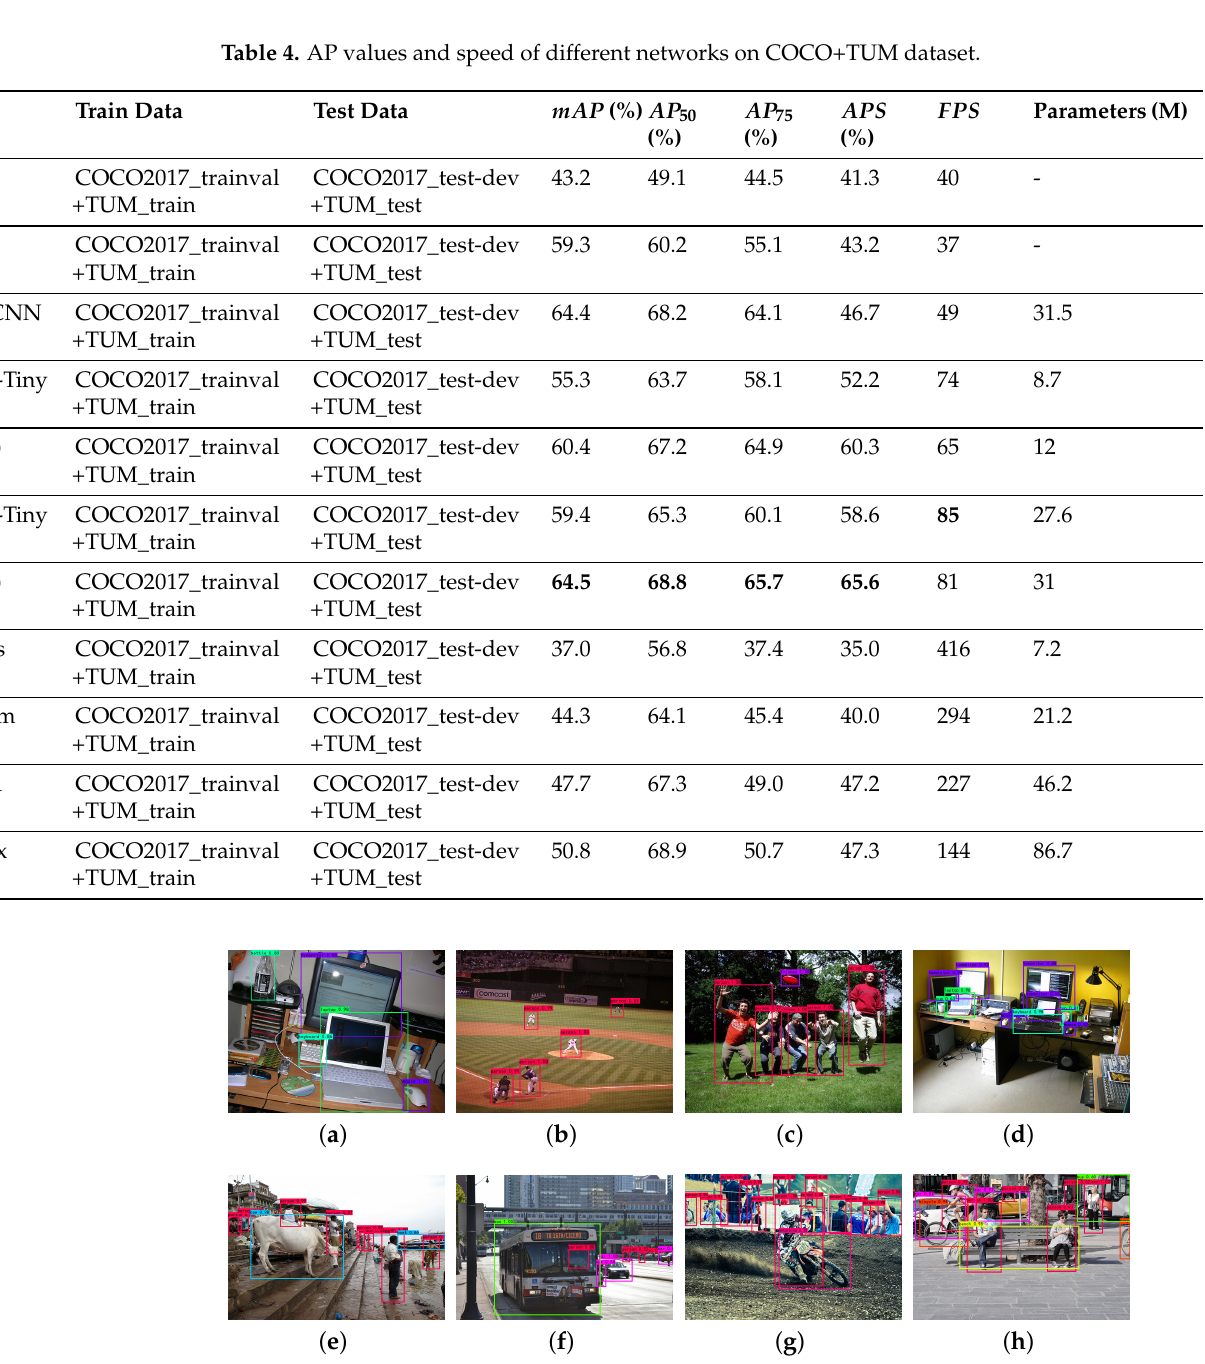
Figure 7. ( a – h ) shows some detection results of the MS COCO2017 dataset with our method. We have performed some experiments to verify the improvement effect of the Vary- Block module on the original YOLOv3-Tiny network. First, we add VaryBlock 1 to Vary- Block 3 into the initial network of YOLOv3-Tiny and compare it with the initial network. Then, we add VaryBlock 4 to VaryBlock 6 for comparison again. The mAP, APS, and FPS in the experiment are shown in Table